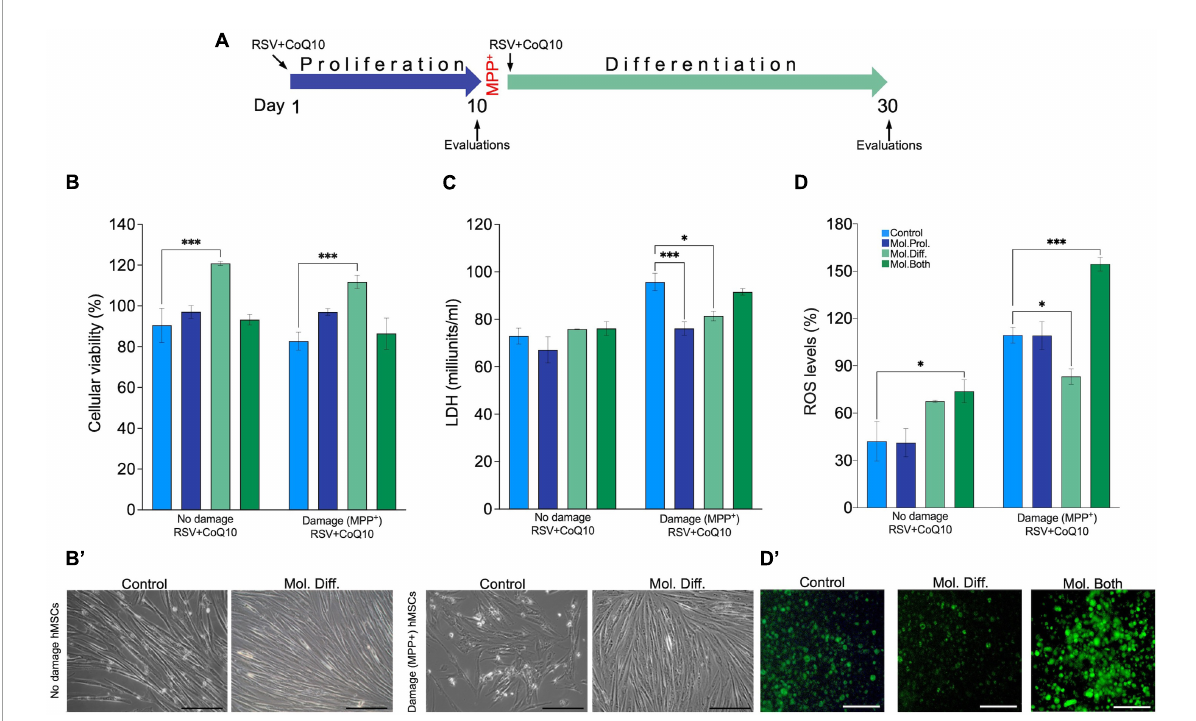
FIGURE4 RSV + CoQ10 on human mesenchymal stem cell (hMSC) damage by MPP+, cellular viability, lactate dehydrogenase (LDH), and reactive oxygen species (ROS) evaluations. (A) Scheme representation of phases of the experiment, damage-induced time, and treatment application. (B) RSV + CoQ10 (2.5/10 µ M) significantly enhances cell viability (%) during the differentiation stage in both no damage and damage hMSCs. (B (cid:48) ) Representative micrographs of cell viability. (C) Lactate dehydrogenase levels were increased in damaged hMSCs by MPP + and decreased posterior to the treatment application in proliferation and differentiation phases. (D) RSV + CoQ10 administration in both phases significantly increased ROS levels with no damage hMSCs. Finally, in hMSCs damage, the treatment increased significantly to apply in differentiation and both phases. (D (cid:48) ) Representative microphotography of fluorescence ROS assay. CoQ10, coenzyme Q10; RSV, resveratrol. ∗ P < 0.05; ∗∗∗ P < 0.001. One-way ANOVA was followed by Dunnett’s test. Scale bar: 100 µ